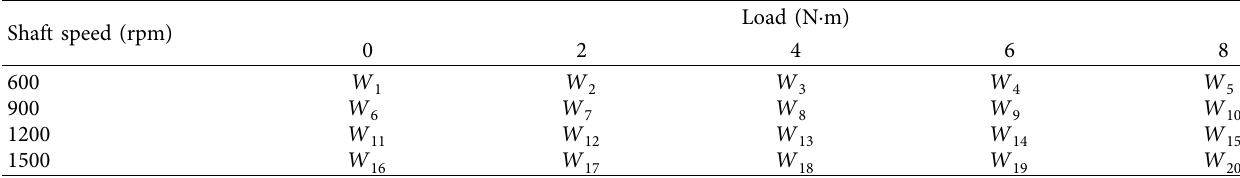
Table 7: 20 different working conditions of the one-stage gearbox.